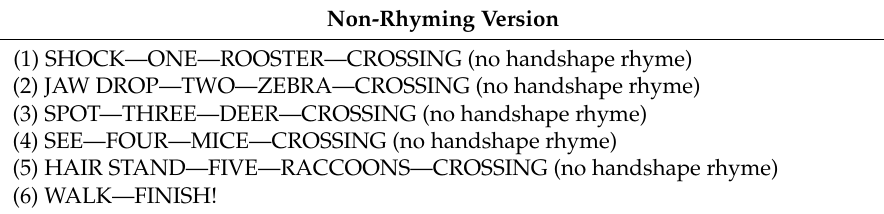
Table 3. Non-Rhyming Version of Animals